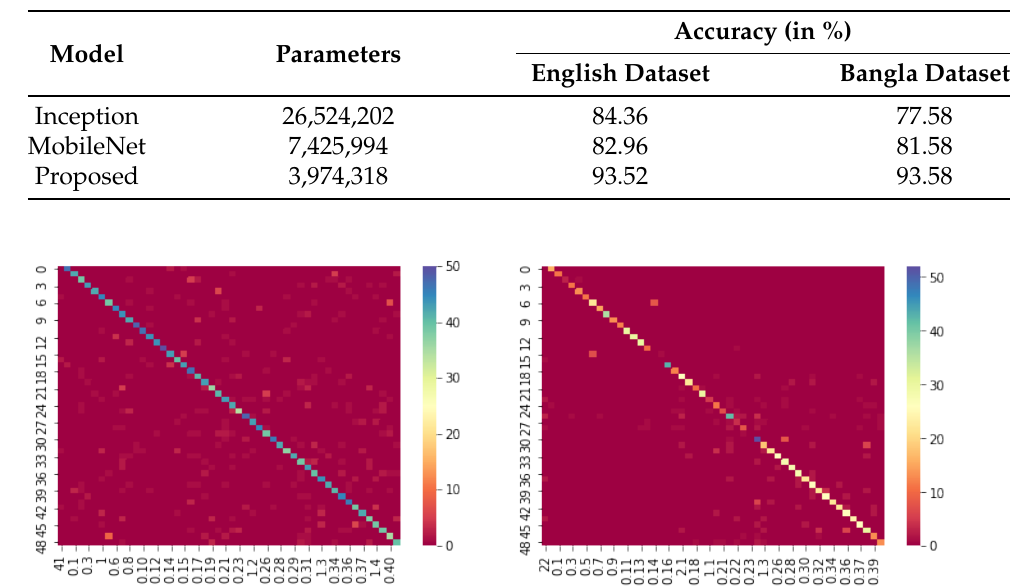
Table 11. Results obtained for the other two CNN models.